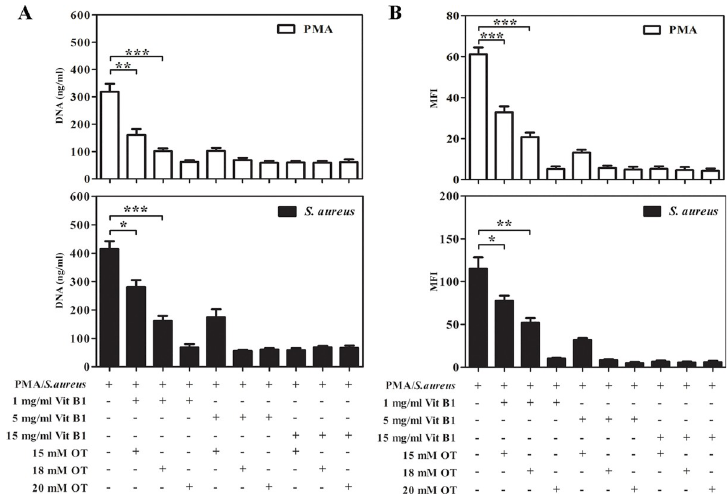
Fig 8. Effect of treatment with TKT inhibitor co-applied with vitamin B1 on NETs and intracellular ROS production. The different doses of oxythiamine and vitamin B1 were co-applied into purified PMNs following stimulation with 100 nM PMA or S . aureus at a MOI of 10. (A) The amount of extracellular DNA was quantified after human PMNs were stimulated. (B) The relative levels of intracellular ROS generation were presented as the MFI from four healthy individuals. Error bar indicates SEM of four independent experiments. � p < 0.05, �� p < 0.01, and ��� p < 0.001.